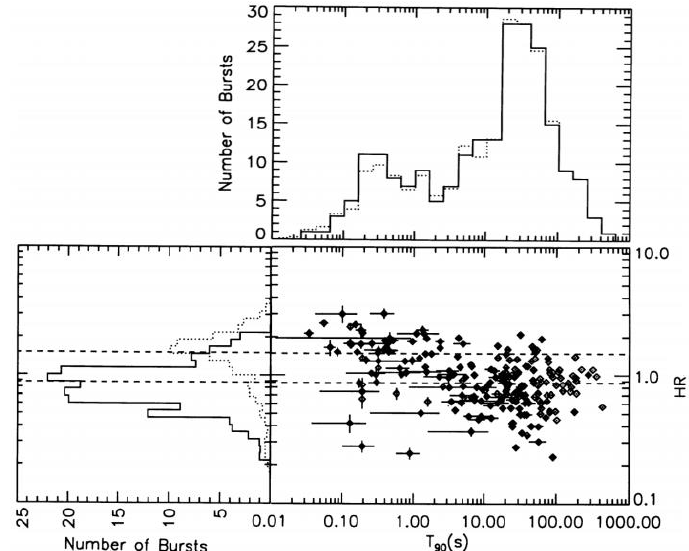
Figure 1. GRB distribution provided by the first BATSE catalog, lying on the t 90 –HR plane. The solid HR histogram shows LGRBs, whereas the dotted one is for SGRBs. The dashed horizontal lines mark mean HRs for both classes. The solid t 90 histogram represents the raw data whilst the dotted one shows the error-convolved data, credit from Ref.